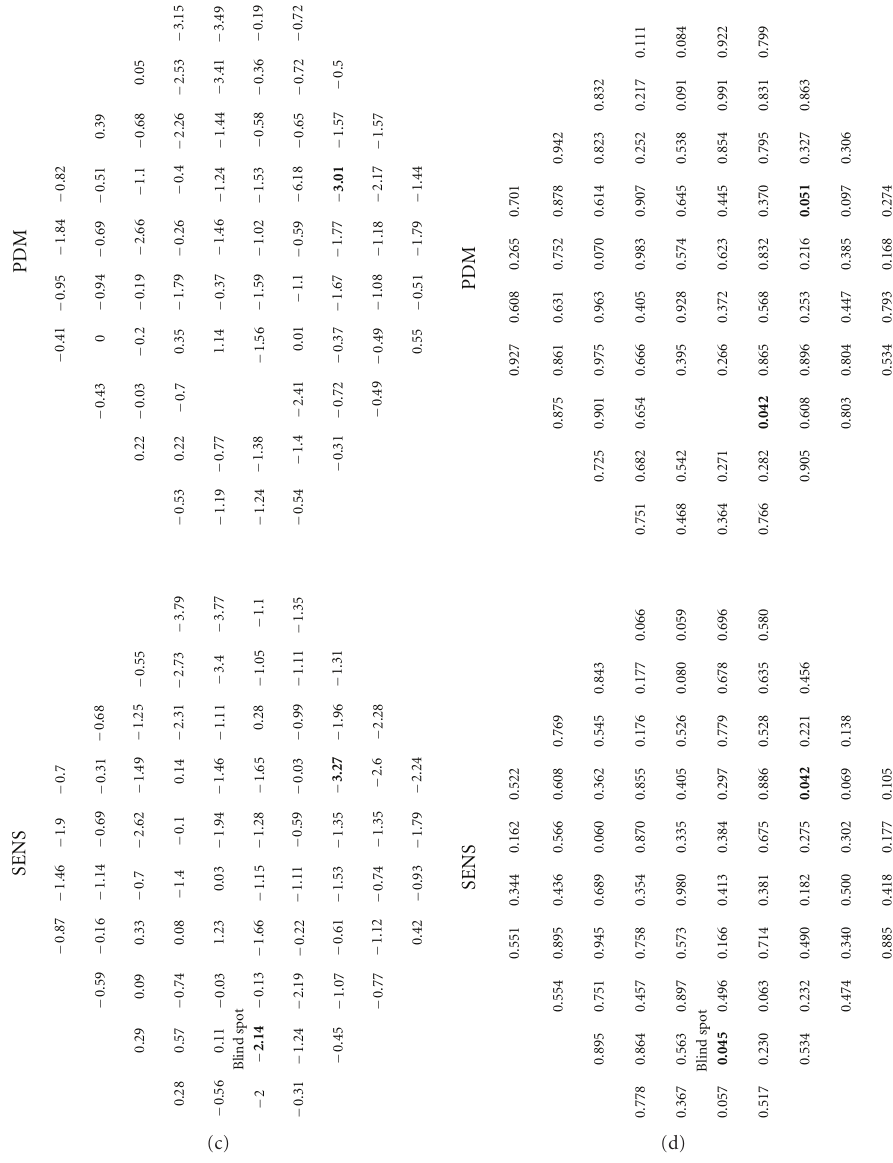
Figure 1: (a) Sensitivity (SENS) and pattern deviation map (PDM) values (mean and standard deviation (SD)) for each point of the visual field in HTG together with the 10 di ff erent glaucoma hemifield test (GHT) areas representation. (b) Sensitivity (SENS) and pattern deviation map (PDM) values (mean and standard deviation (SD)) for each point of the visual field in NTG together with the 10 di ff erent GHT areas representation. The di ff erent colours represent the di ff erent areas used by the GHT. (c) Di ff erence of the sensitivity (SENS) values and the pattern deviation map (PDM) values pointwise between HTG and NTG. (d) Comparison ( P values) of the di ff erence pointwise of the sensitivity (SENS) values and the pattern deviation map (PDM) values between HTG and NTG. Bolding indicates a significant di ff erence between the two